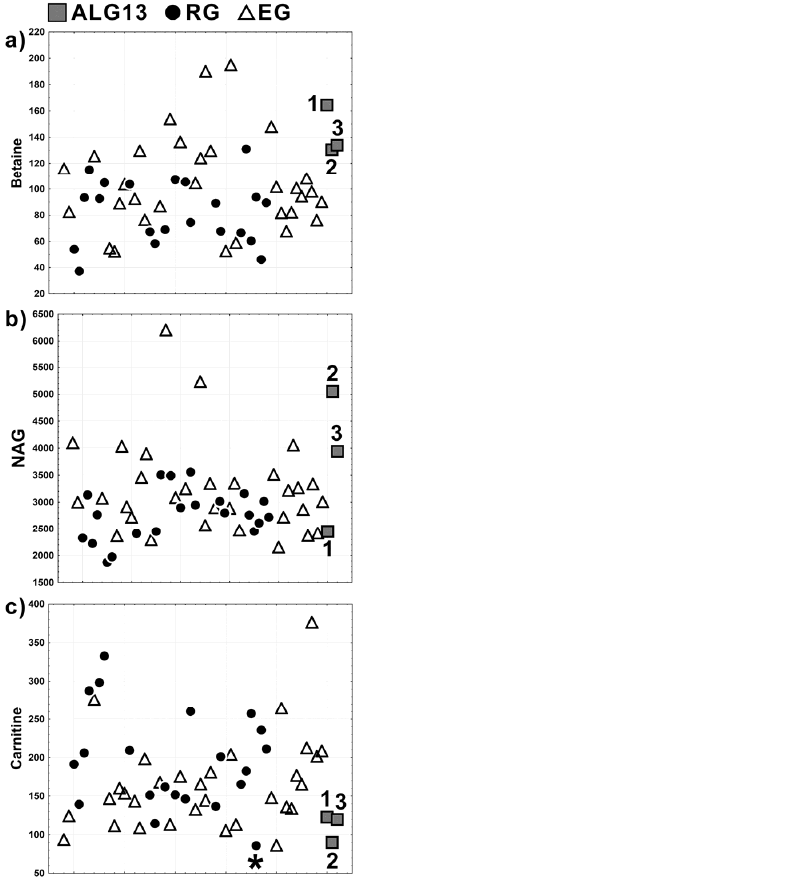
Figure 4. Differences in the relative intensities of betaine ( a ), N-acetyl-glycoprotein ( b ), and carnitine ( c ) among the RG ( • ), EG ( ∆ ), and ALG13 ( (cid:3) ) groups. The ALG13 cases: 1—Patient 1, 2—Patient 2, and 3—Patient 3. (cid:81) denotes the outlying sample from RG due to the lowest level of carnitine in this group. The points in the plot as well as the x axis scale correspond to individual patients. Table 2. The p -values from Kruskal–Wallis ANOVA showing the statistical differences in the rela- tive intensities of betaine, NAG, and carnitine between the RG and EG groups and three ALG13 cases.